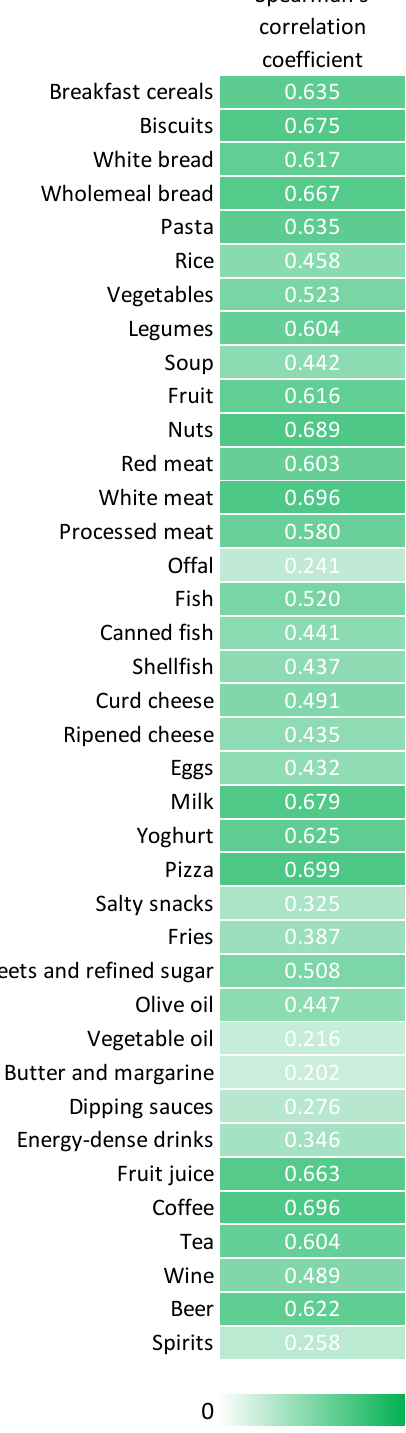
Figure 4. Spearman’s correlation coefficients of dietary data obtained from the web-app and the food frequency questionnaire.